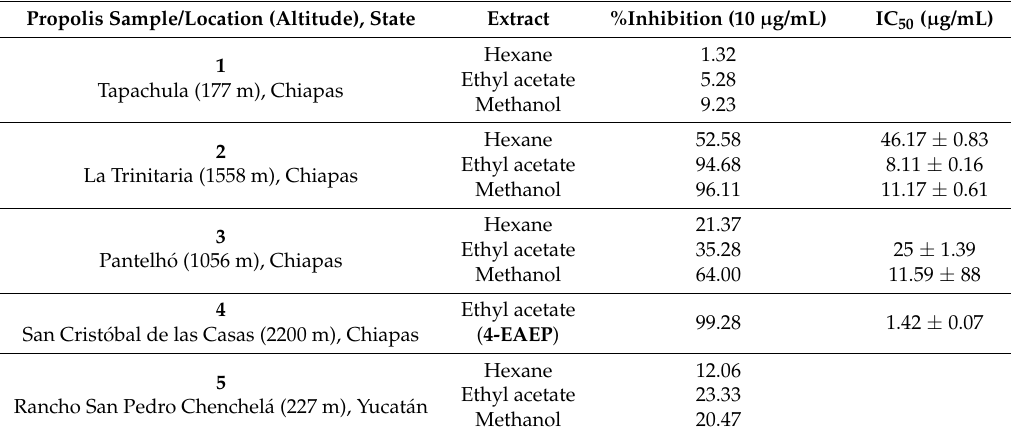
Table 1. Propolis from M é xico and screening activity of their extracts in TBARS assay. Propolis Sample/Location (Altitude), State